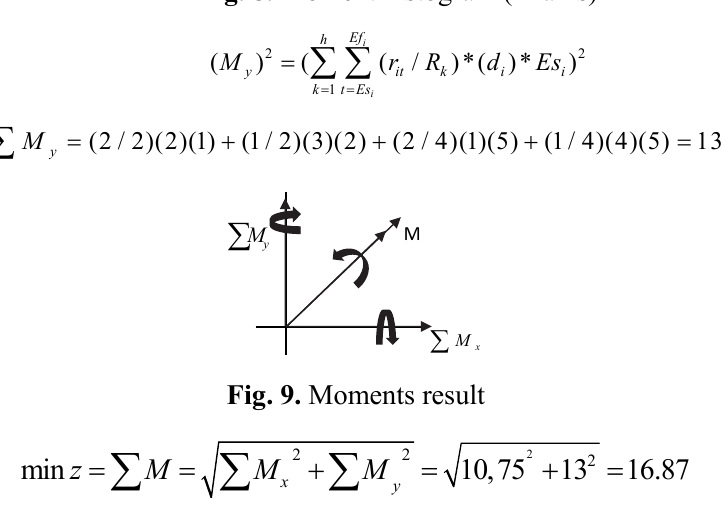
Fig. 8. Moment histogram (Y-axis)